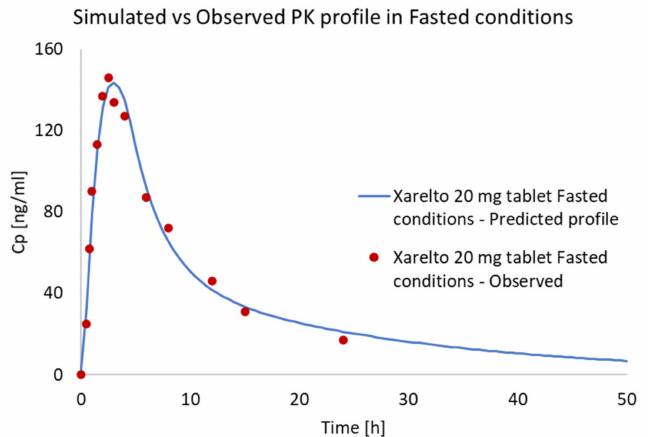
Figure 11. Internal validation (Xarelto 20 mg tablet Fasted condition) of the in vitro–in vivo correla- tion (IVIVC) model.